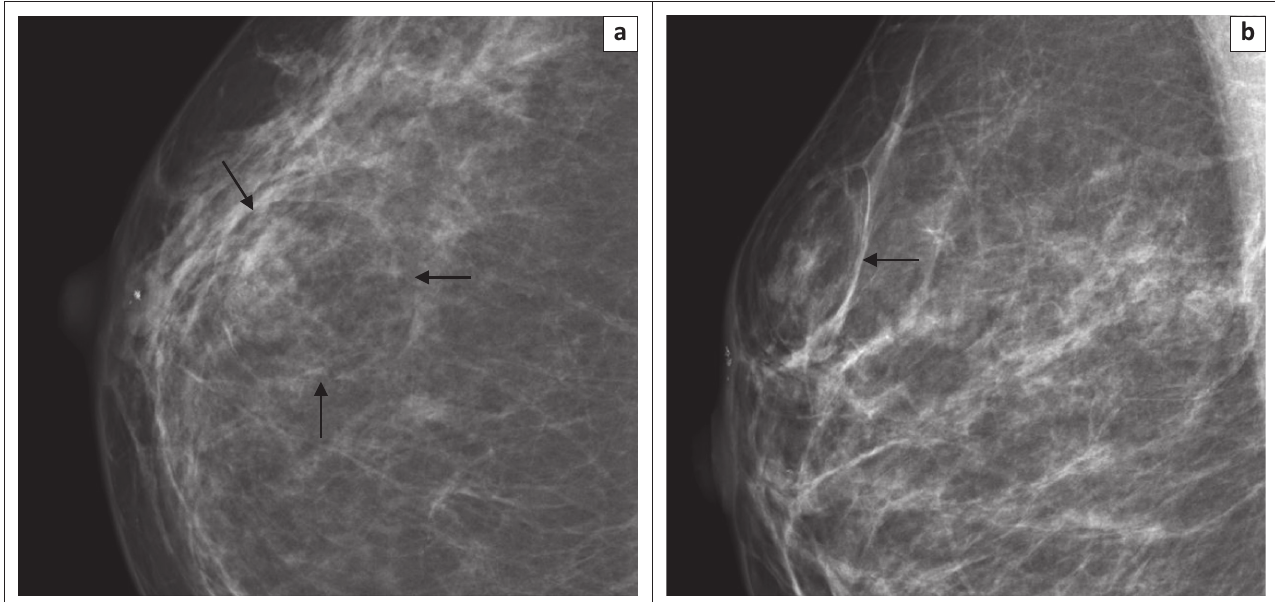
FIGURE 1: Craniocaudal (a) and mediolateral oblique (b) mammogram views of the right breast, demonstrating a well-circumscribed heterogeneous mass in the supra-areolar region of the right breast (arrows). Note the radiodense pseudocapsule.